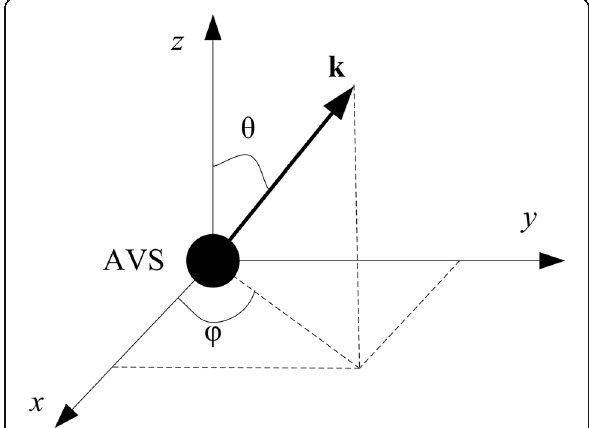
Fig. 1 The first AVS of the array and the wave vector of the impinging signal in the Cartesian coordinate